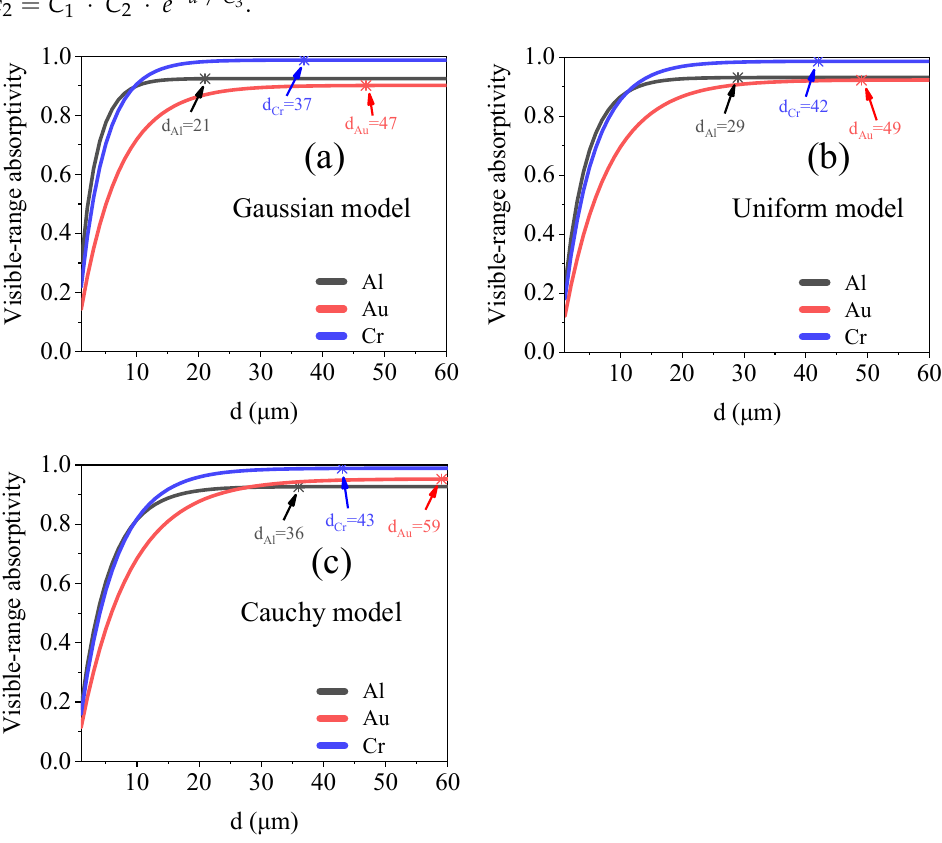
Figure 6. Relationship between optical absorption and thickness for ( a ) Gaussian, ( b ) uniform, and ( c ) Cauchy models. Critical thicknesses of models are shown in the figures.